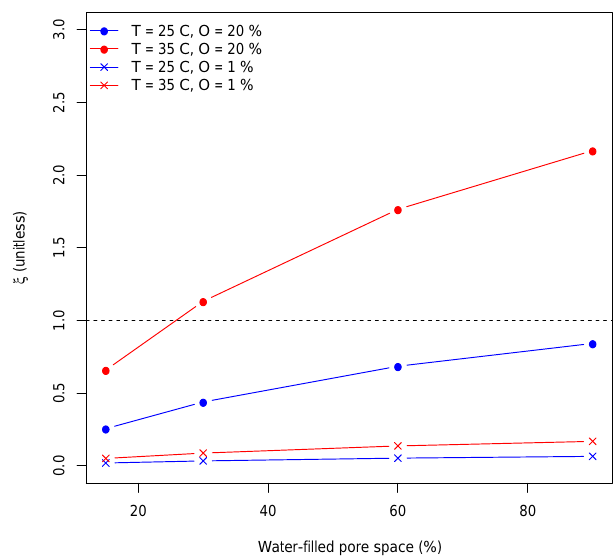
Figure 5. The average value of the decomposition modifier ξ = f (T ) · f (M) · f (O) predicted for the values of temperature, mois- ture, and oxygen levels applied to all treatment combinations in our experiment. Values above 1 increase decomposition rates, and val- ues below 1 reduce